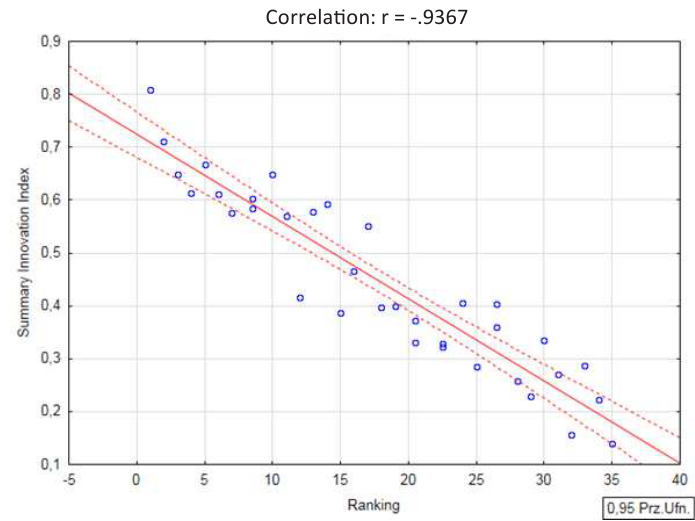
Figure 7. Relationship between the ranking of countries and the